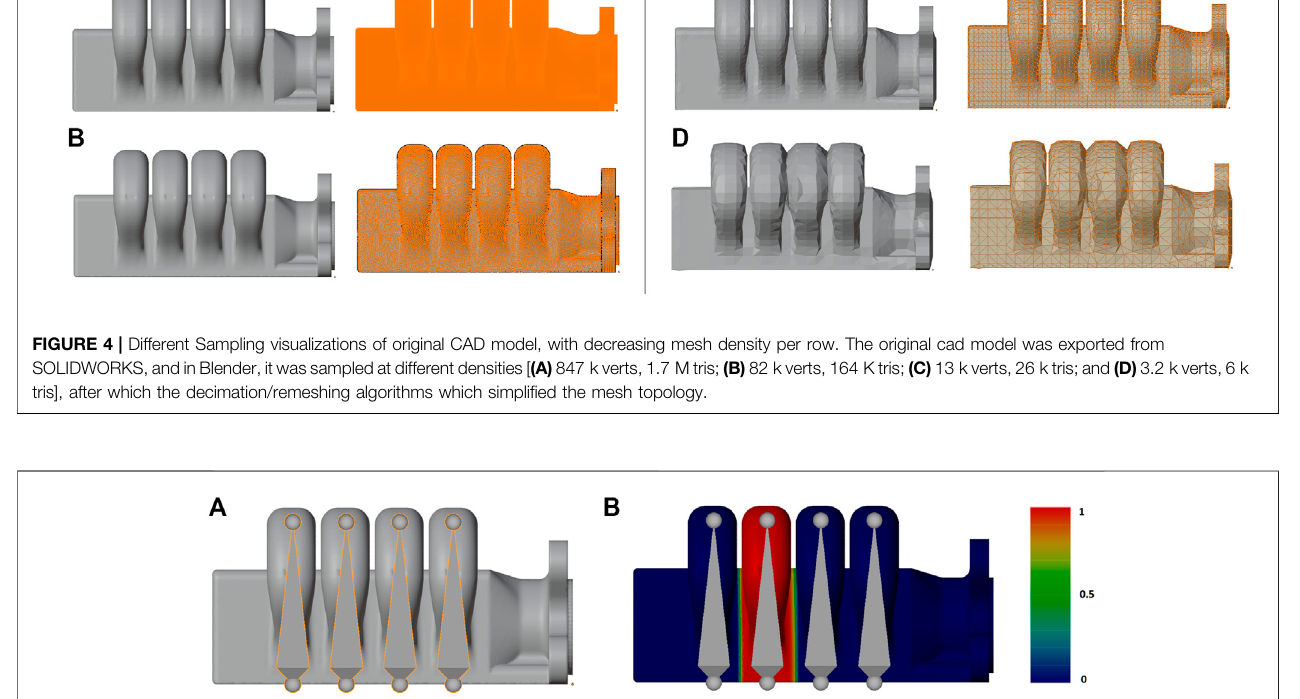
FIGURE5|(A) Riggedsimpli fi ed3Dactuatormodel,alongwith (B) ,showingtheweightpaintinggradientforthethirdbone[fromred(maximumvertexin fl uence)to dark blue — zero in fl uence] for one bellow and its corresponding bone. This gradient is a visual representation of the vertex weights set for this mesh for the third bone (Scharff et al.